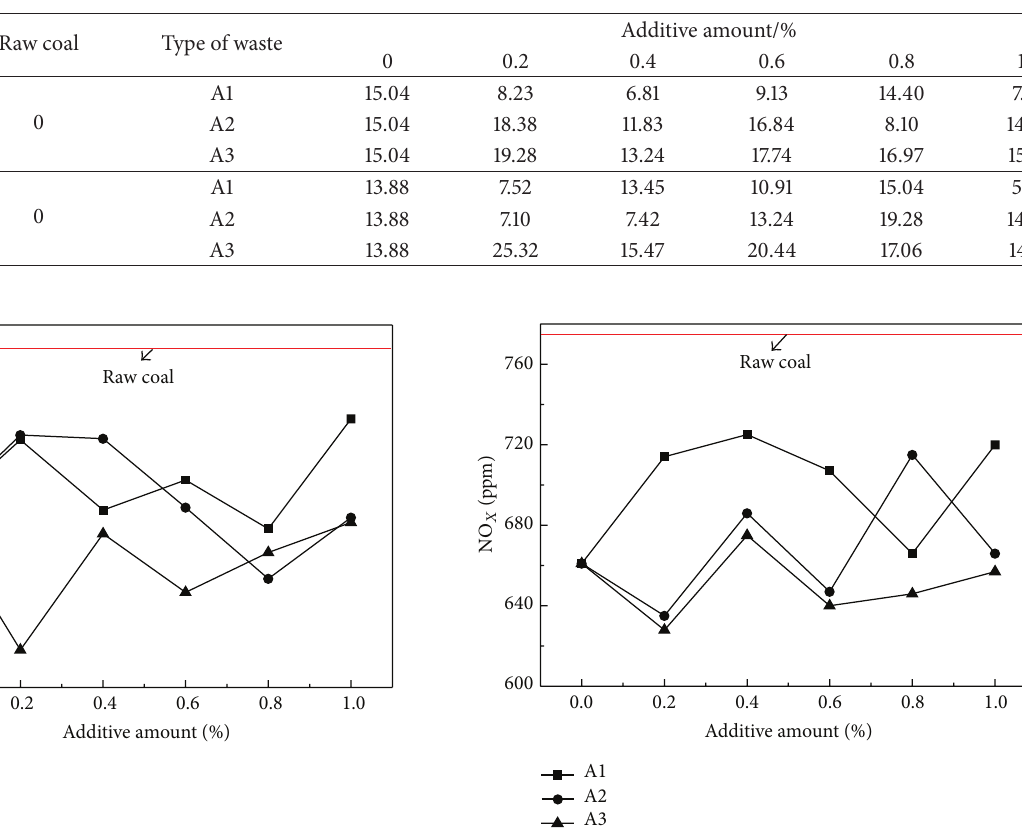
Table 3: The effect of different additives on denitrification efficiency of C1 and C2 (%).